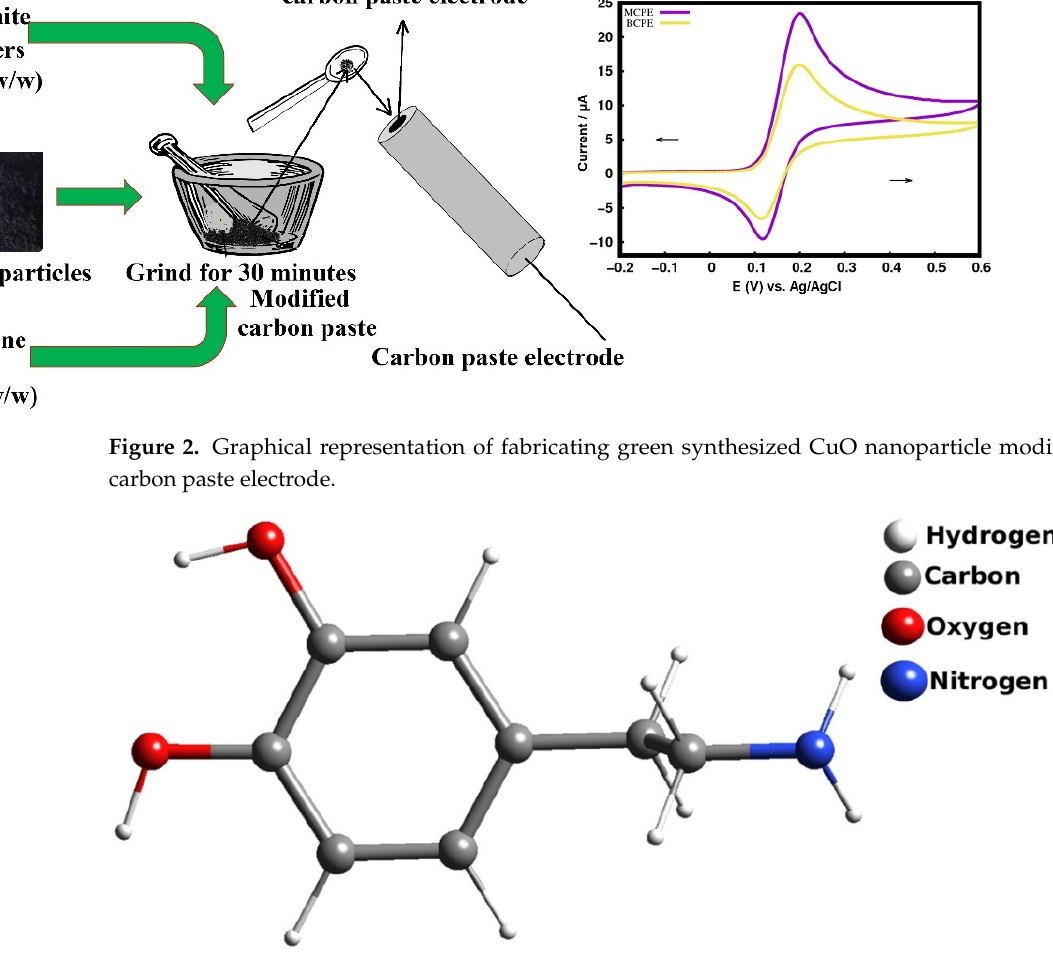
Figure 3. The DA structure drawn using Sinapsis software tool.